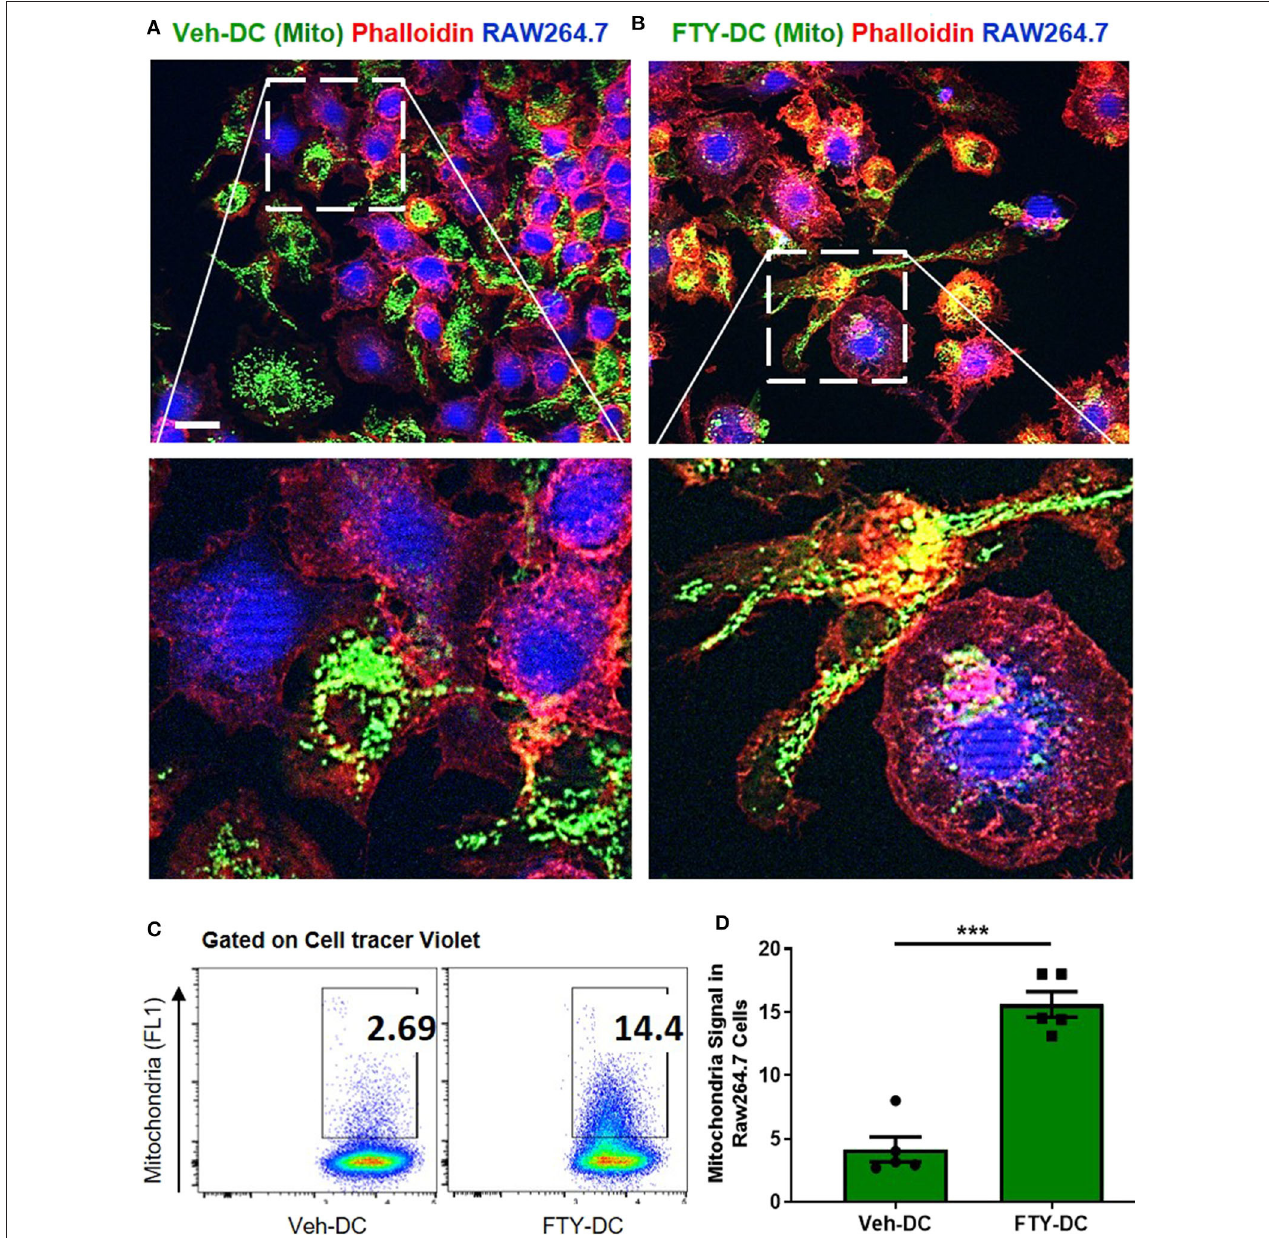
FIGURE 7 | Dendritic cells transfer mitochondria to macrophages. (A) Co-culture of 1:1 of macrophages (RAW264.7, blue, cell tracer violet) and CD11cCrePham fl / fl BMDCs (Veh-DC, green, mitochondria) and labeled with phalloidin (red, actin) was done after 24h. (B) Co-culture of 1:1 of macrophages and CD11cCrePham fl / fl BMDCs (FTY-DC). Scale bar, 20 µ m. (C,D) Flow cytometry of co-culture and semi-quantitative analysis after 24h was done by gating on cell tracer violet positive RAW264.7 cells. Data represent means ± SEM, *** p ≤ 0.001. One of three experiments is shown.